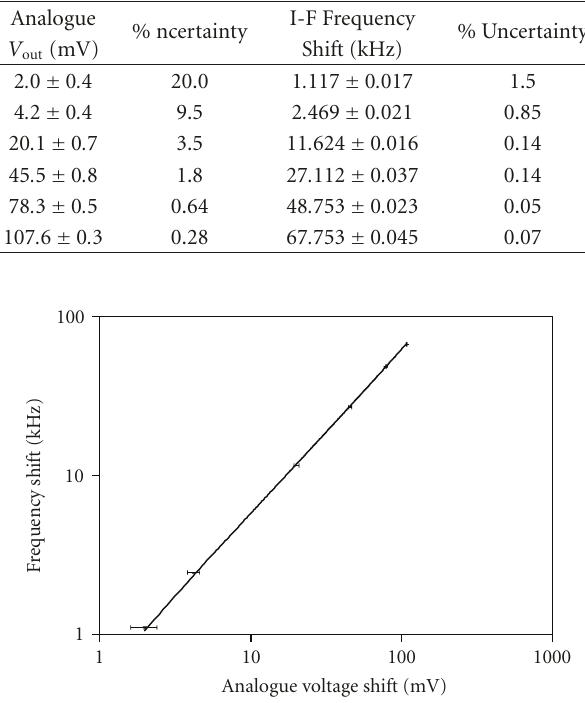
Figure 7: Graph of output Frequency versus. Analogue Voltage out- put from bu ff er. Note that this gives a sensitivity of 0.631 kHz/mV = 631 Hz/mV.